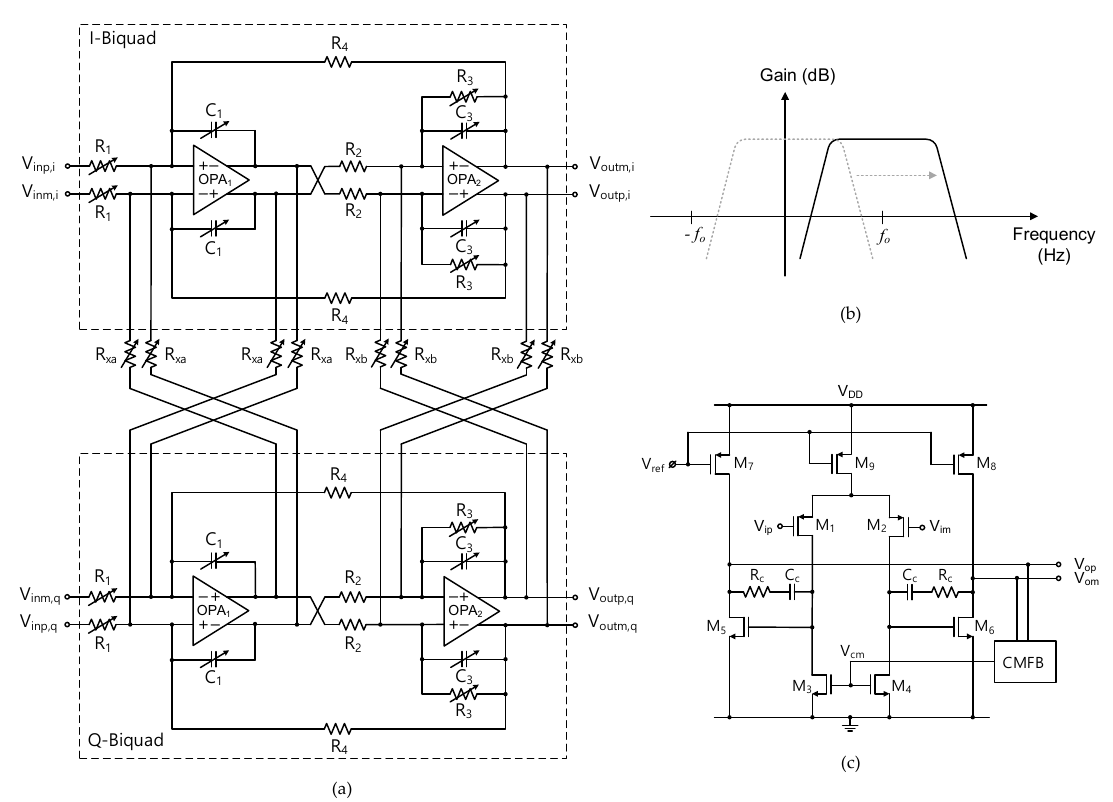
Figure 4. Complex biquad. ( a ) Block diagram, ( b ) transfer characteristics, ( c ) operational amplifier schematic. The LO signal is generated by the fractional-N PLL frequency synthesizer. A 20-bit digital delta-sigma ( ∆∑ ) modulator is employed for the fractional-N frequency